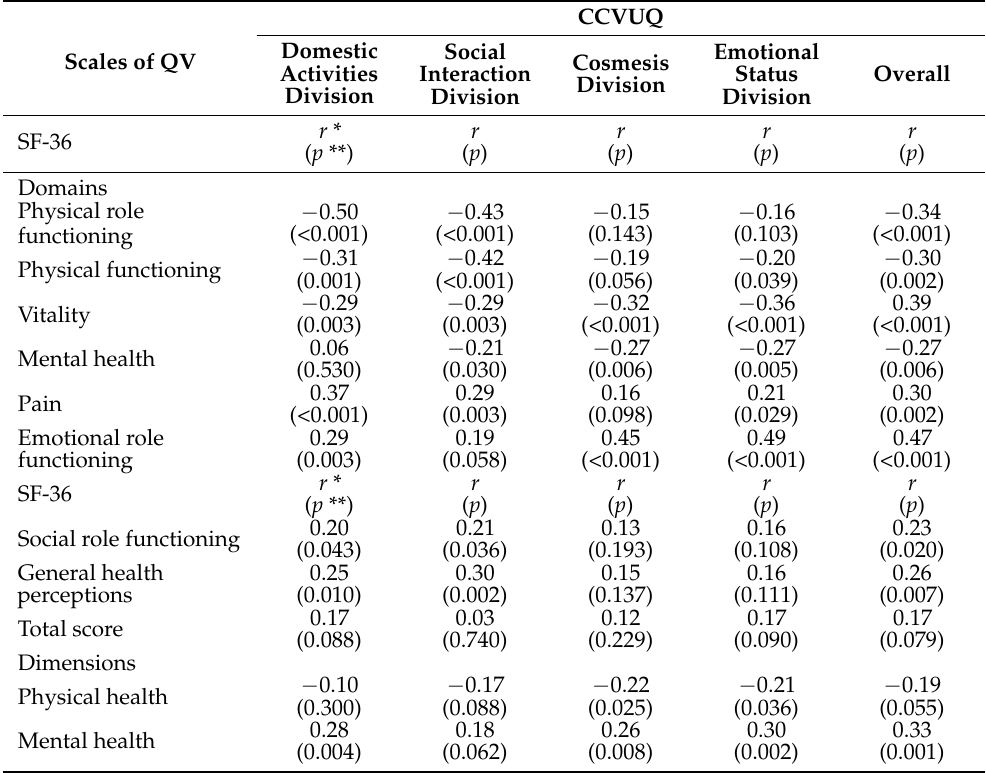
Table 3. Correlation between the aspects evaluated in the SF-36 and CCVUQ scales among the participants.